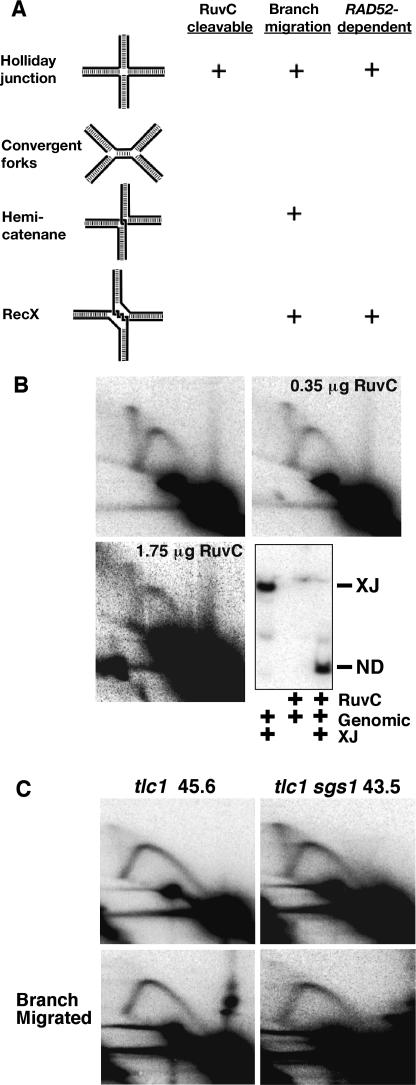
Characterization of Telomere X-Structures(A) Structures of different X-shaped DNA molecules, their susceptibility to cleavage by RuvC, their ability to branch migrate, and their dependence on RAD52.(B) ClaI-digested DNA from tlc1 sgs1 cells at PD 55 was incubated with RuvC buffer alone (top left), with 350 ng (top right) or 1.75 μg (bottom left) of purified RuvC for 3 h at 37 °C prior to 2DGE. Note that the blot of sample treated with the highest level of RuvC is a longer exposure to show the similar degree of loss of X-structures and of Y-type replication structures. RuvC (350 ng) under these conditions fully digested a synthetic X-junction (XJ) that was added to the genomic DNA digests (bottom right). In these controls, genomic DNA was present in all reactions at the same concentration used for 2DGE, and XJ DNA and RuvC were added as indicated; bands corresponding to the XJ and the nicked duplex product (ND) are also indicated. A similar lack of selective X-structure cleavage was observed in tlc1 mutants, and in samples treated between the first and second dimensions (unpublished data).(C) Prior to the second dimension, first-dimension gel slices containing DNA from tlc1 and tlc1 sgs1 mutants at the indicated PD were incubated for 4 h in branch migration buffer at 65 °C (bottom panels) or 4 °C as a control (top panels).